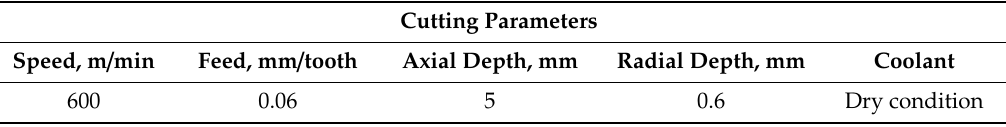
Table 2. Cutting parameters used for the tool-life